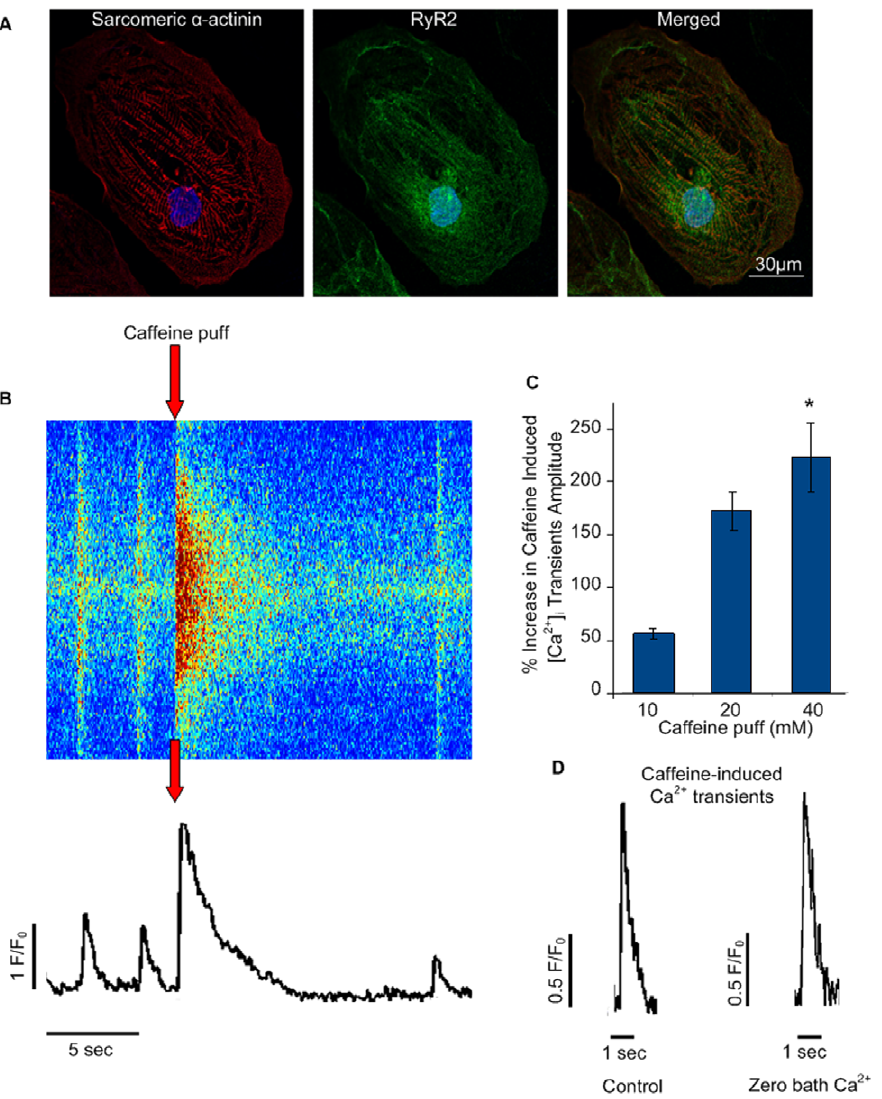
Figure 3. Localization and functionality of Ca 2 + store ryanodine receptors. ( A ) A hIH1 hiPSC-CM co-labeled with antibodies for sarcomeric a -actinin (left) and RyR2 (middle). The merged image is displayed in the right panel. ( B ) A line-scan presenting the effect of 20 mM caffeine puff application (noted by the arrows). ( C ) A dose-response curve displaying the magnitude of the caffeine-induced Ca 2 + release (quantified by the percentage increase of the amplitude of the caffeine-induced transient relative to the preceding action-potential induced [Ca 2 + ] i transient) as function of the caffeine bolus dosage (10, 20 and 40 mM). *p , 0.05 when compared to the lowest (10 mM) dosage. ( D ) A line-scan tracings presenting caffeine-induced Ca 2 + transients in the presence (left) and absence (right) of bath Ca 2 + . Abbreviations: F/Fo, fluorescence (F) normalized to baseline fluorescence (Fo); sec, seconds.